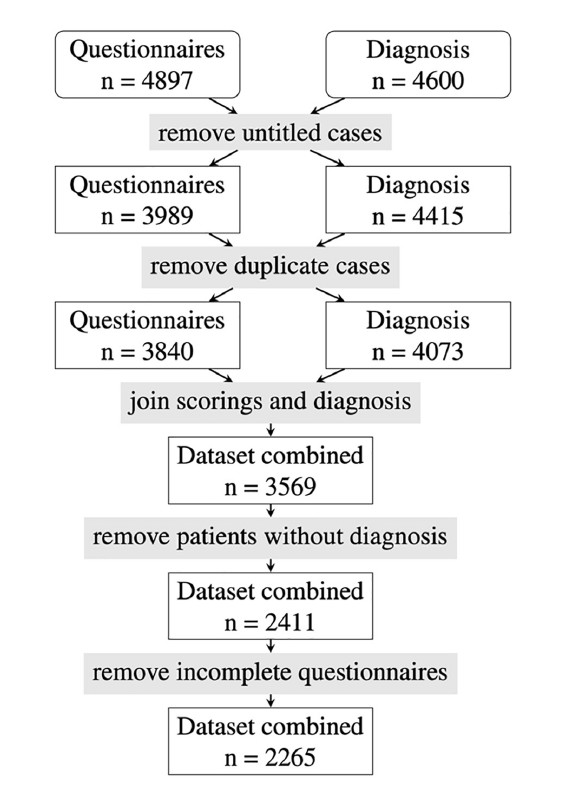
FIGURE1 Flowchart of patient case